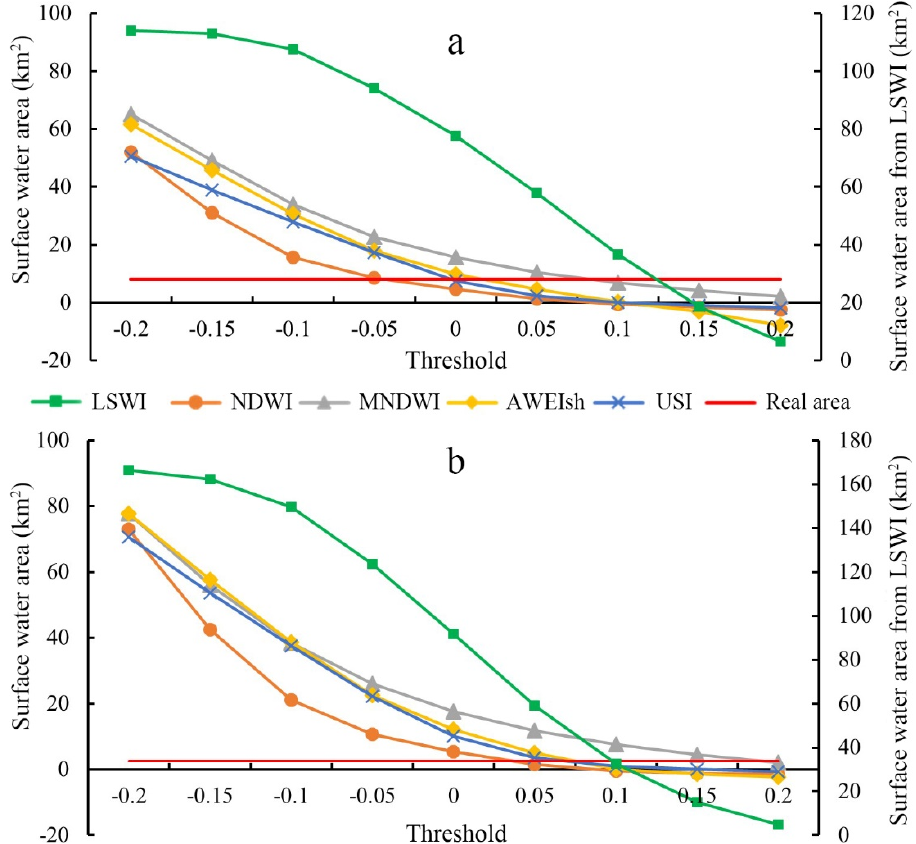
Figure 11. Water areas from five water indexes with various thresholds: ( a ) experimental area A and ( b ) experimental area B. The abbreviations of LSWI, NDWI, MNDWI, AWEIsh, and USI in the figure represent Land Surface Water Index, Normalized Difference Water Index, Modified Normalized Difference Water Index, Automated Water Extraction Index for shadow, and Urban Shadow Index, respectively.